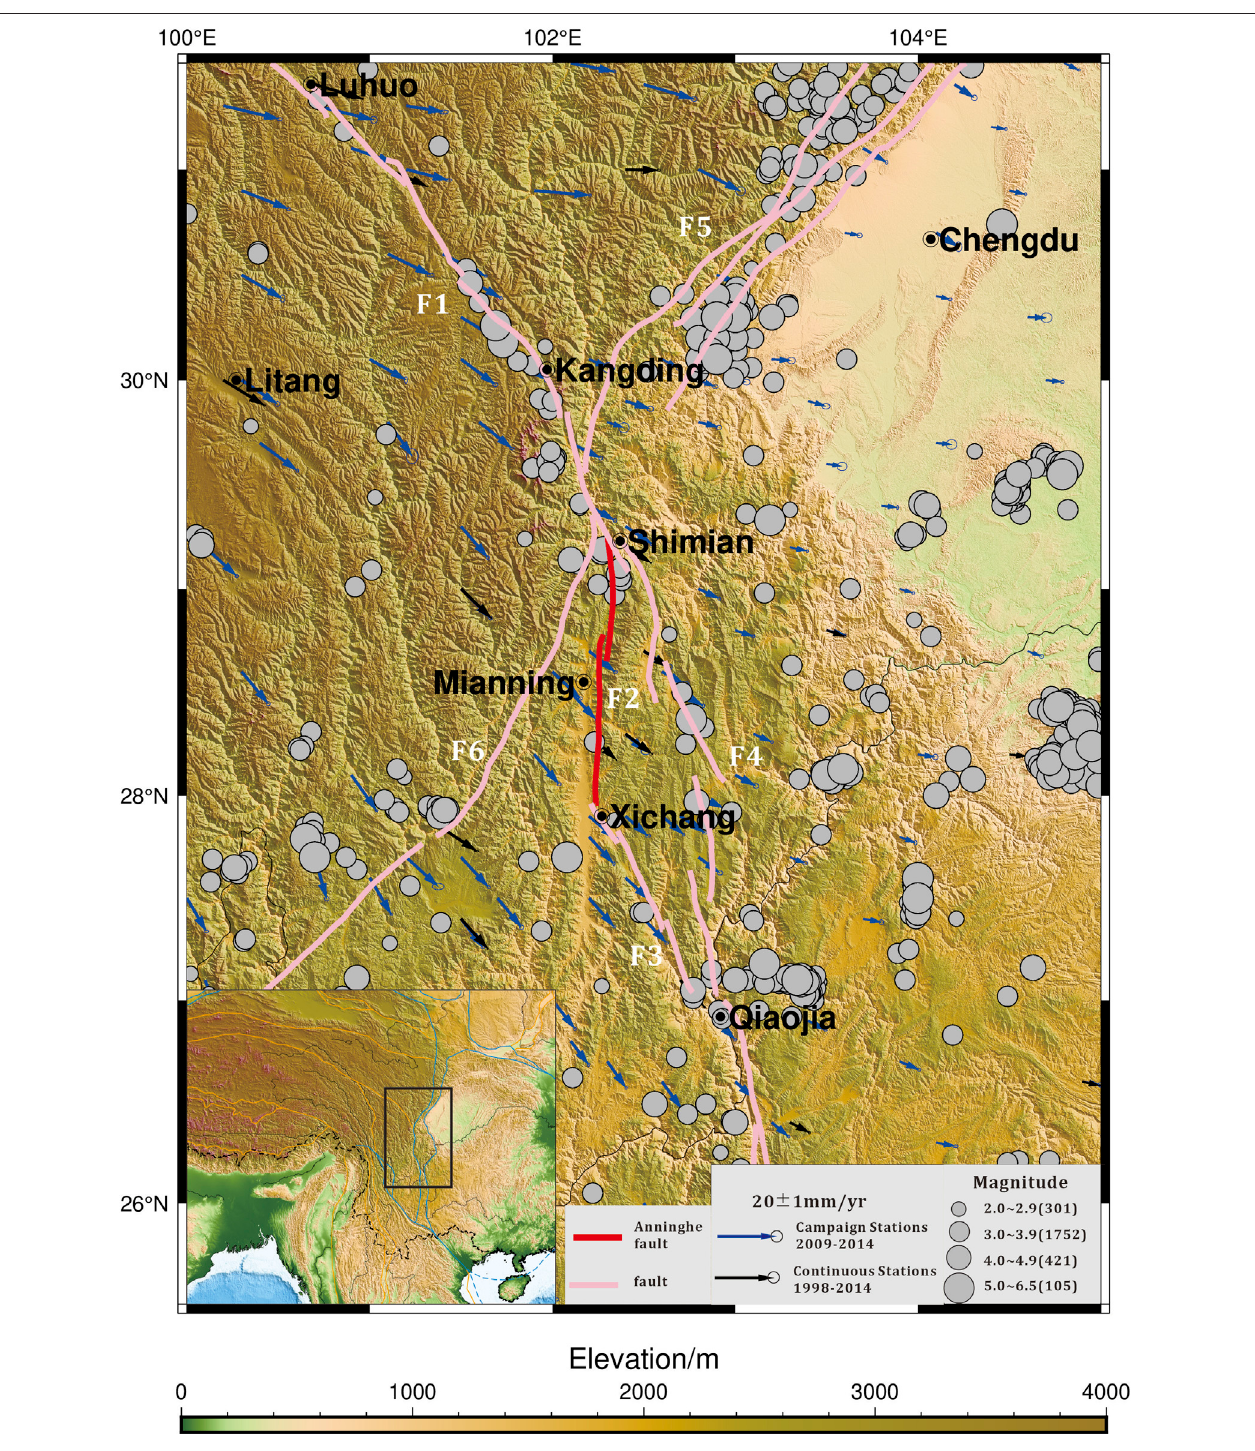
FIGURE1| TectonicandtopographicmapofeasternmarginoftheTibetanPlateau.F1:Xianshuihefault,F2:Aninghefault,F3:Zemuhefault,F4:Daliangshanfault, F5:Longmenshanfault,F6:Lijiang-Xiaojinhefault.BlueandblackvectorsshowGPSvelocity fi eldofcrustalmotionineasternmarginoftheTibetanPlateaurelativetothe stable Eurasia. Gray small circles show epicenters of earlier documented historical earthquakes (2012 – 2021).